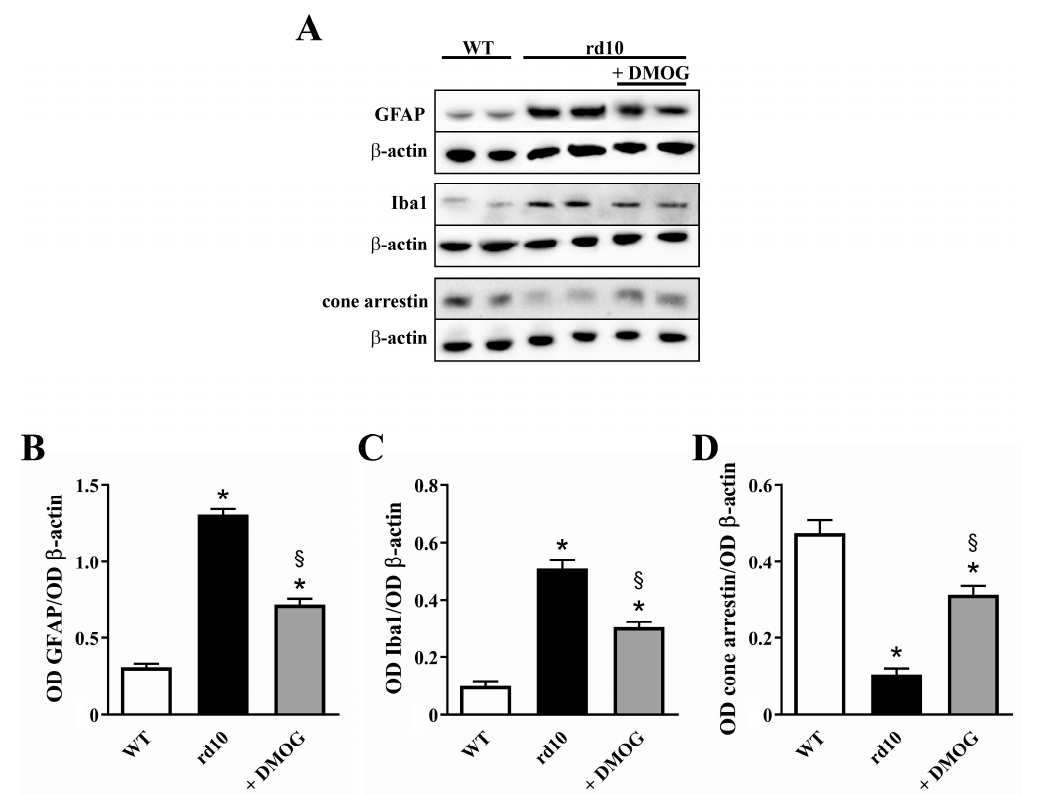
Figure 7. Expression of glial fibrillary acidic protein (GFAP), ionized calcium binding adaptor molecule 1 (Iba1) and cone arrestin in the retina of untreated WT and rd10 mice either untreated or treated with DMOG. ( A ) Representative Western blots from retinal homogenates. ( B – D ) Densitometric analysis of GFAP ( B ), Iba1 ( C ) and cone arrestin levels. In rd10 mice, DMOG decreased GFAP and Iba1 levels, while increased cone arrestin levels ( n = 5 samples per group, each containing 2 retinas from independent mice). * p < 0.001 versus WT; § p < 0.001 versus untreated rd10 (one-way ANOVA followed by the Tukey post-hoc test).